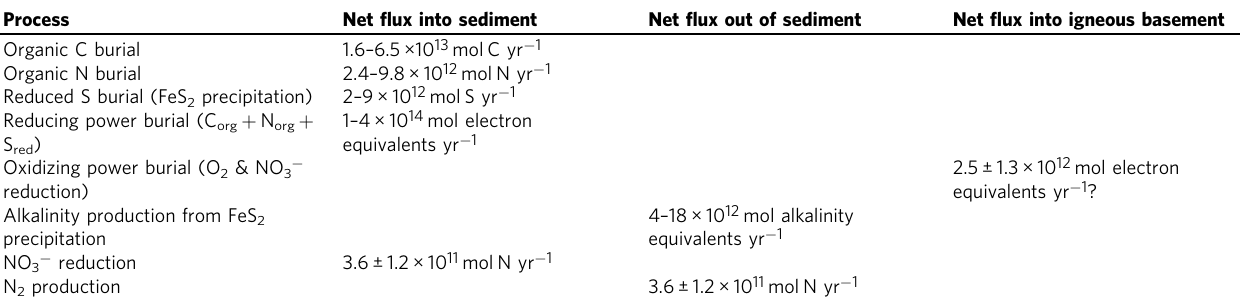
Table 1 Major net chemical fl uxes due to microbial activities in subsea fl oor environments. Organic carbon burial fl ux estimates from Sarmiento and Gruber 35 and Dunne et al. 37 . Estimates of NO 3 − fl ux to sediment and N 2 fl ux from sediment from Gruber 50 . All other fl uxes calculated as described in the text. As described in the text, the extent to which microbial activities are responsible for the net oxidizing fl ux into the igneous basement is not yet known Process